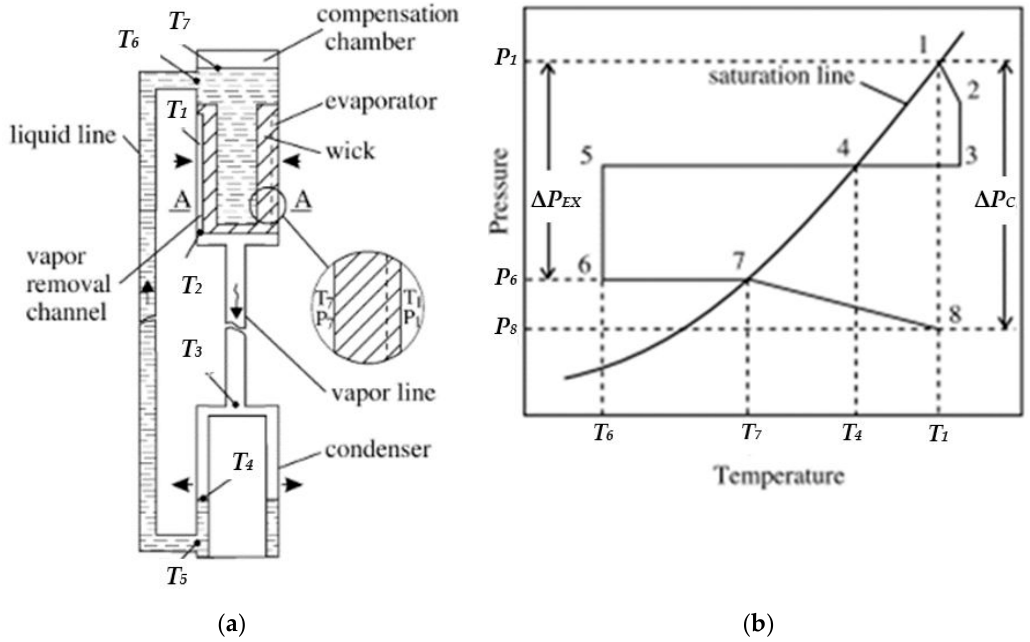
Figure 1. Principles of LHP: ( a ) Scheme of analytical LHP. ( b ) LHP working cycle diagram. Reproduced from [1], Yu.F.Maydanik: 2005.